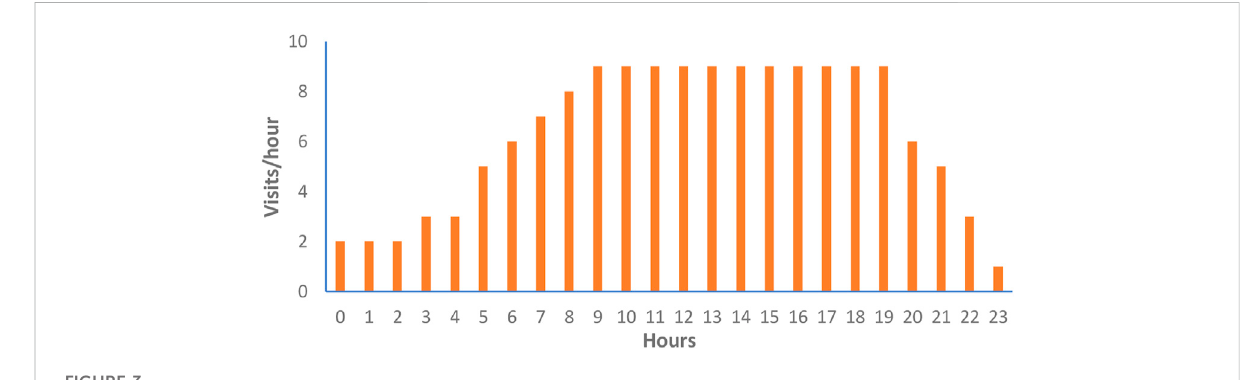
FIGURE 3 Electric vehicle visits pro fi le at the charging station.